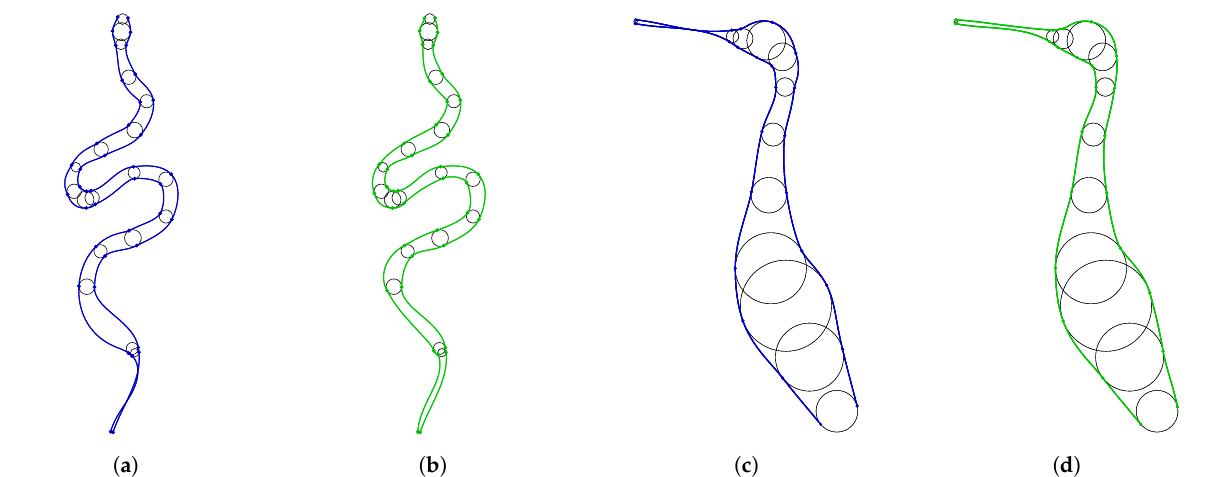
Figure 4. Comparison of the previous method [22] and our solution. ( a ) Snake model using the solution in [22]. ( b ) With our method, the unintended broader parts of the snake and intersections at the tail have been eliminated. ( c ) Crane bird model with the method in [22]. ( d ) By using our solution, we obtain the bill of the crane without